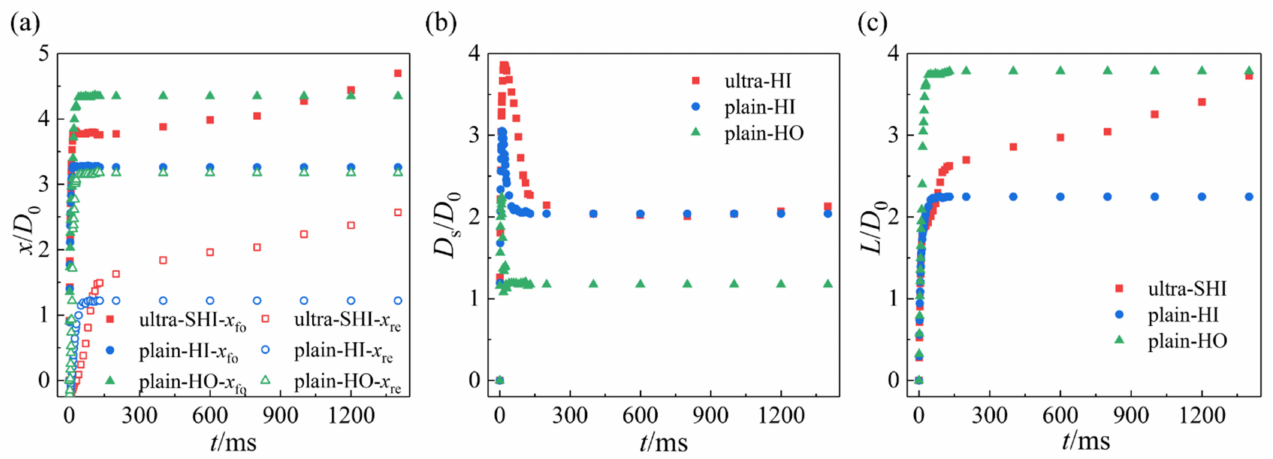
Figure 8. Evolution and slipping distance of the droplet impact on inclined surfaces. ( a ) Displacement of the foremost point x fo and the rearmost point x re of the droplet over time t on the test surface. ( b ) Spreading diameter of the droplet D s / D 0 over time t on the test surface. ( c ) Slipping distance of the droplet L / D 0 over time t on the test surface. We = 28.71. The inclination angle of the surface is 45 ◦